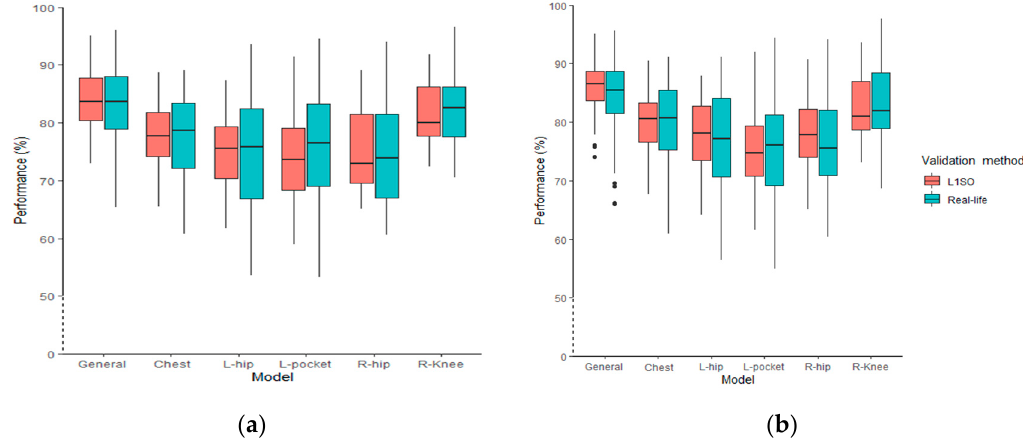
Figure 6. The distribution of overall accuracy among all participants for the RF classification models trained combined dataset, ( a ) accelerometer data only and ( b ) accelerometer and GPS data.